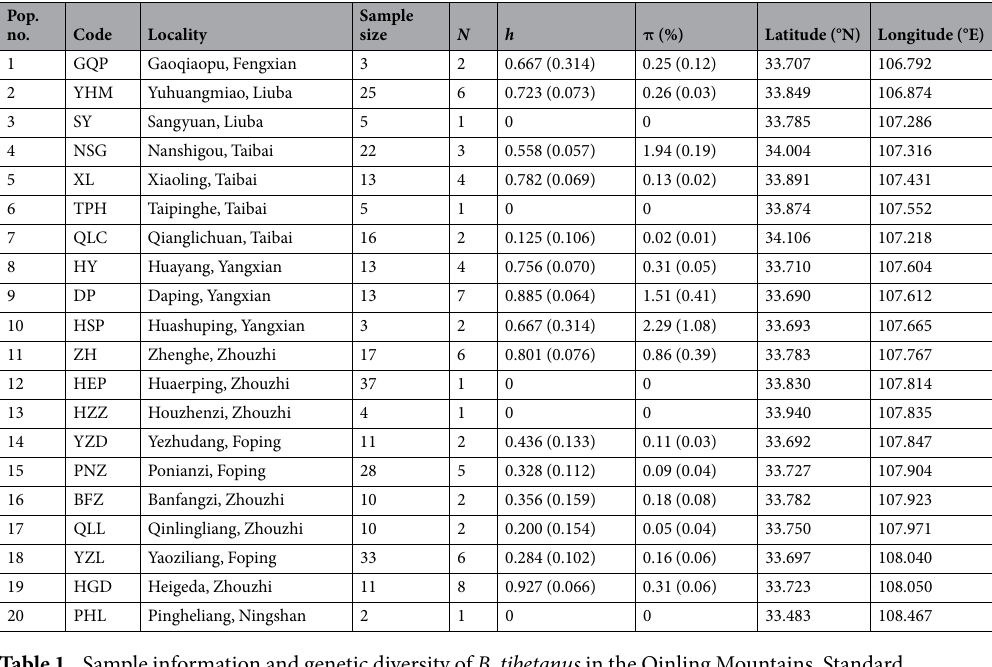
Table 1. Sample information and genetic diversity of B . tibetanus in the Qinling Mountains. Standard deviation of h and π estimates are shown in parentheses. N , the number of haplotypes; h , haplotype diversity; π , nucleotide diversity.